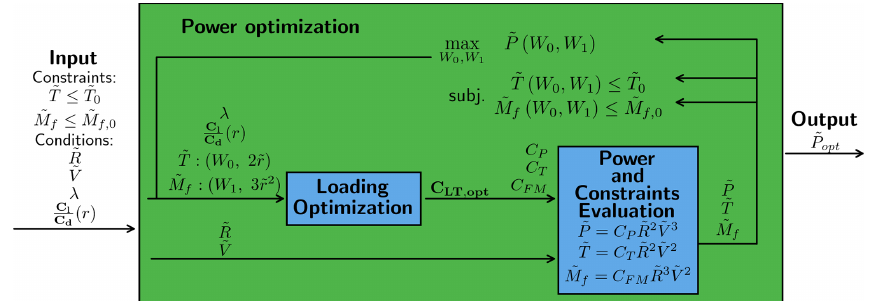
Figure 3. Flowchart for power optimization. Note that the loading optimization is nested within the optimization loop. The optimizer needs to adjust the W 0 and W 1 for maximum power while the constraints are